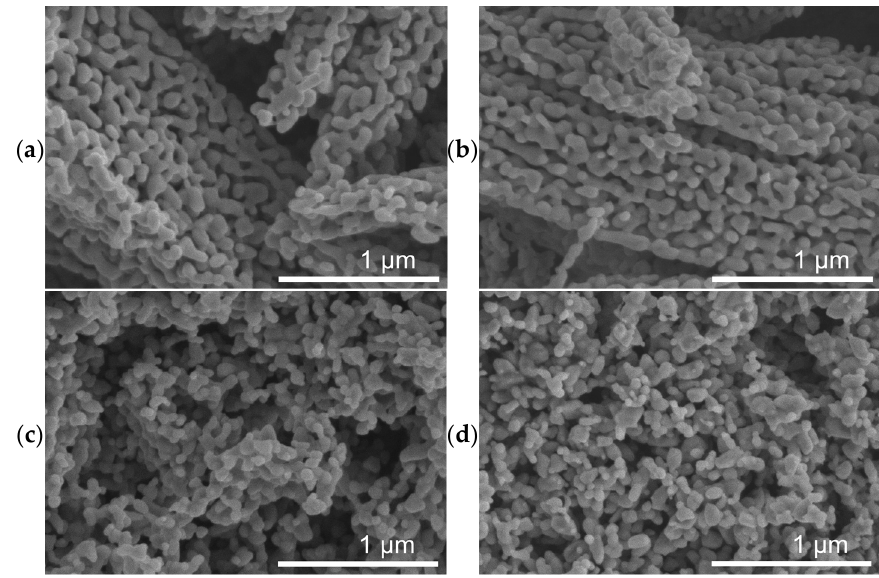
Figure 3. SEM images of ( a ) spent FeO x , ( b ) spent 1%-Cu/FeO x , ( c ) spent 3%-Cu/FeO x , and ( d ) spent 5%-Cu/FeO x showing major restructuring at the micrometer and sub-micrometer scale. Additional images are shown in Figure S10.